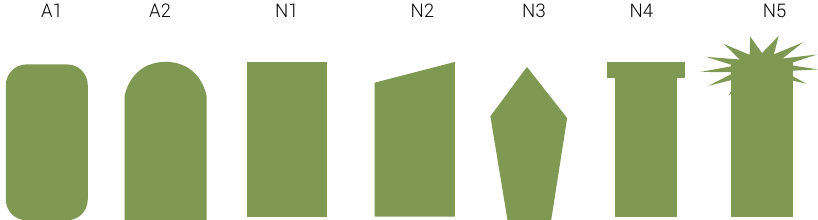
Figure 2. Classification of bristle tip morphology. Group A represents the acceptable rounding of the tip of the bristles, and group N represents the non-acceptable rounding of bristles tips. Statistical